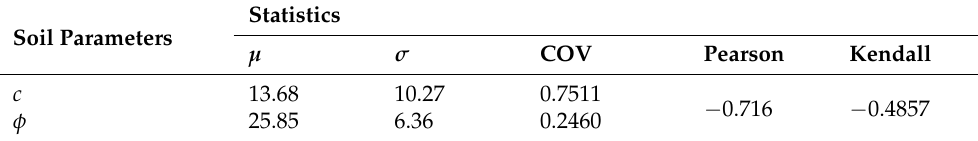
Figure 25. Observations of soil parameters in Papillion River Basin slope. Table 9. Statistics of soil parameters in Papillion River Basin slope. Table 9. Statistics of soil parameters in Papillion River Basin slope.